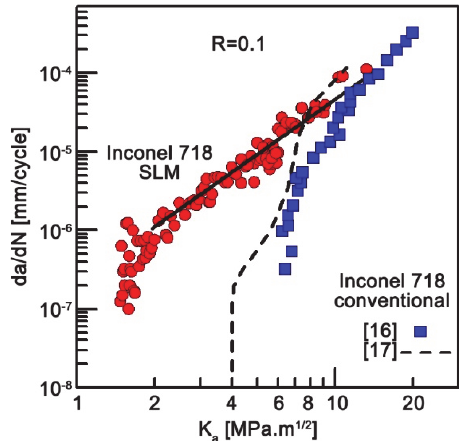
Figure 13: Comparison of crack growth in Inconel 718 manufactured conventionally and by